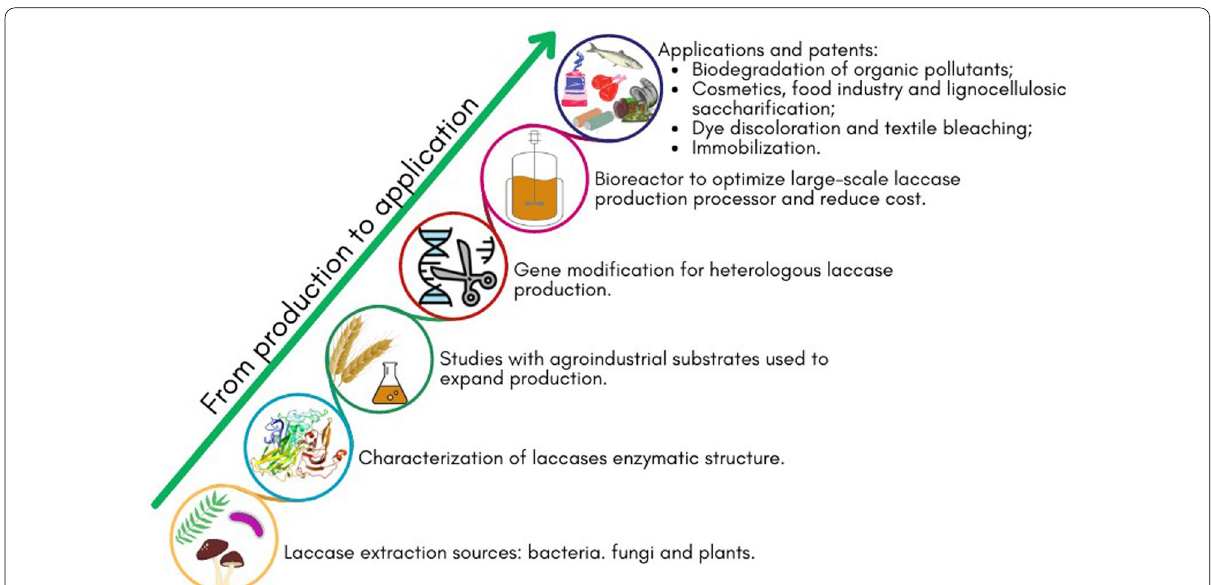
Fig. 3 Main steps to achieve large-scale laccase production: laccase extraction sources, selection of suitable and low-cost substrates, enzyme characterization, genetic modifications for improved enzymatic production and bioreactor cultivation. These stages are fundamental for laccase